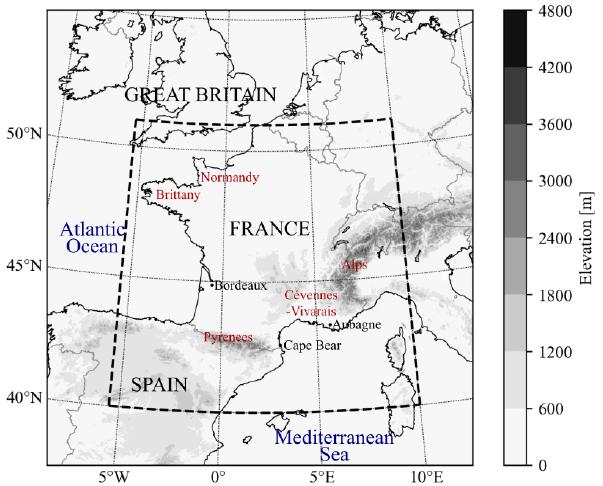
Figure 2. The AROME-France domain and topography. The dashed rectangle shows the limits of the sub-domain where the synthetic MTG-LI data are generated. Locations mentioned in the text are also